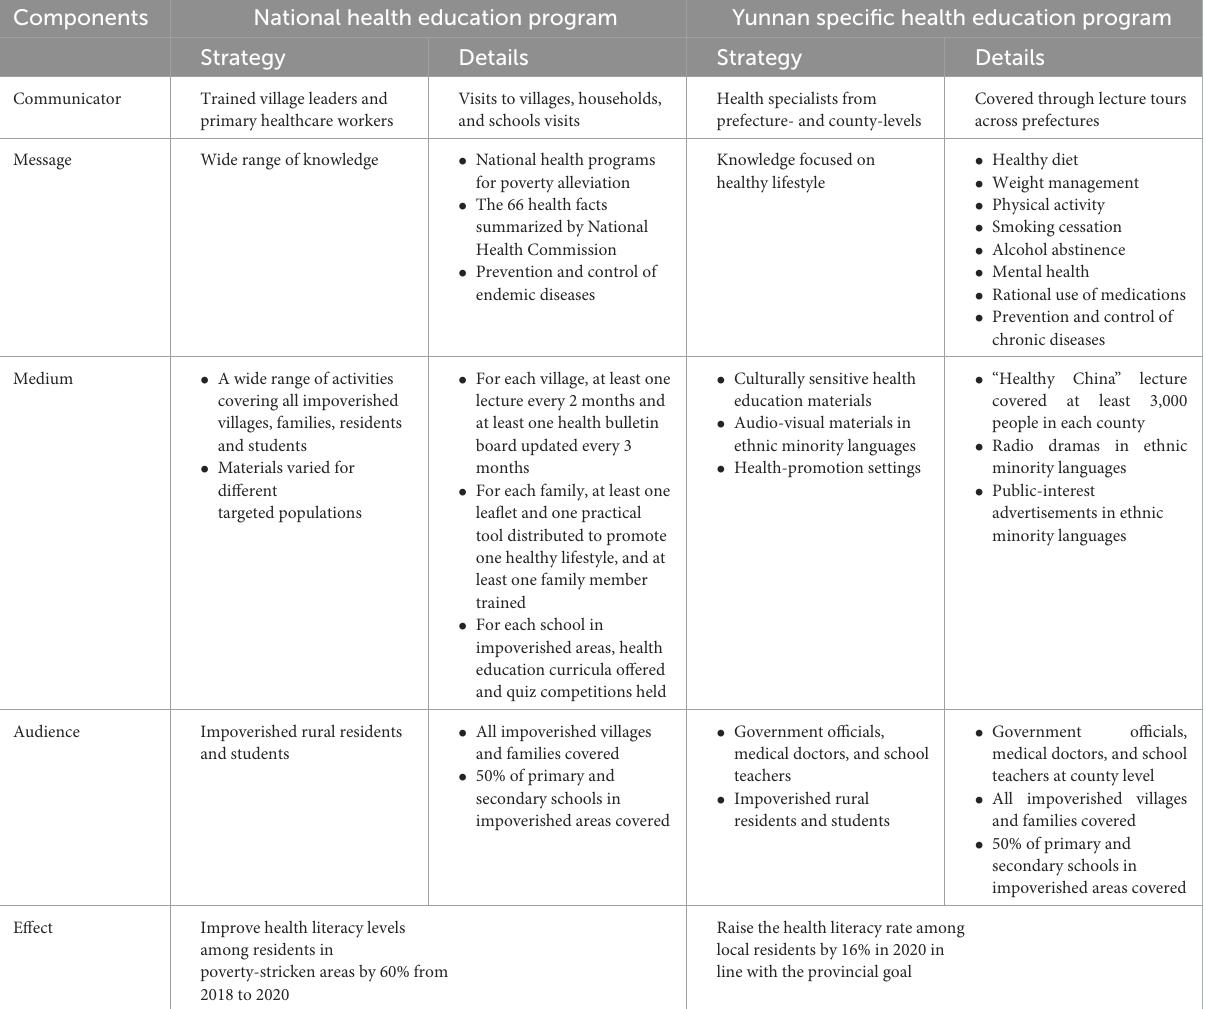
TABLE 1 Characteristics of two health education programs by Lasswell’s model.